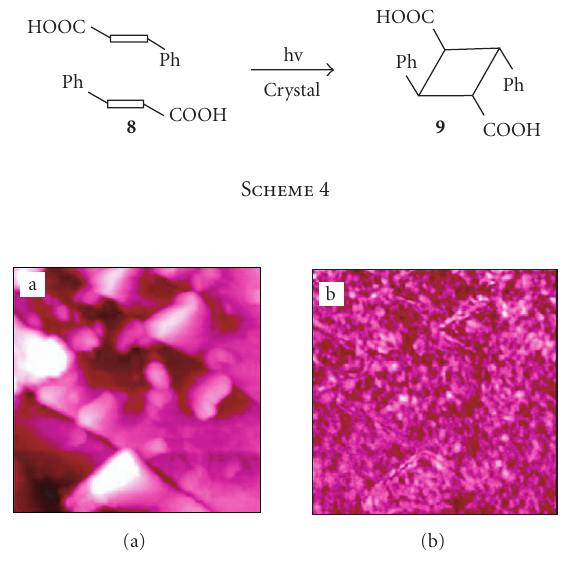
Figure 7: Simultaneous AFM (a) (11 μ m, Z range 1.5 μ m) and aper- tureless shear-force SNOM (b) of the (010)-face of α -cinnamic acid ( 8 ) after 15min irradiation at λ > 290nm showing anisotropically grown features along the cleavage planes direction and only slight local steepness contrast but no chemical contrast.